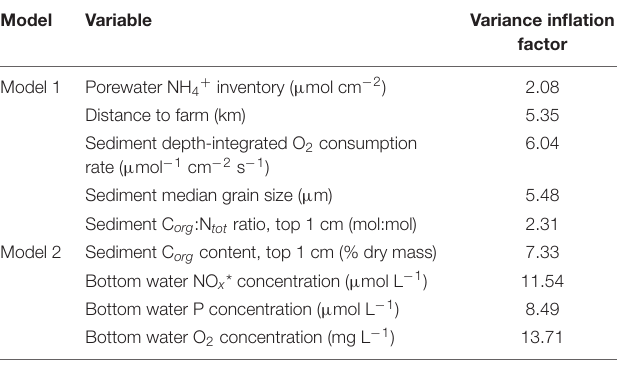
TABLE 4 | Physical and chemical variables used for db-RDA model